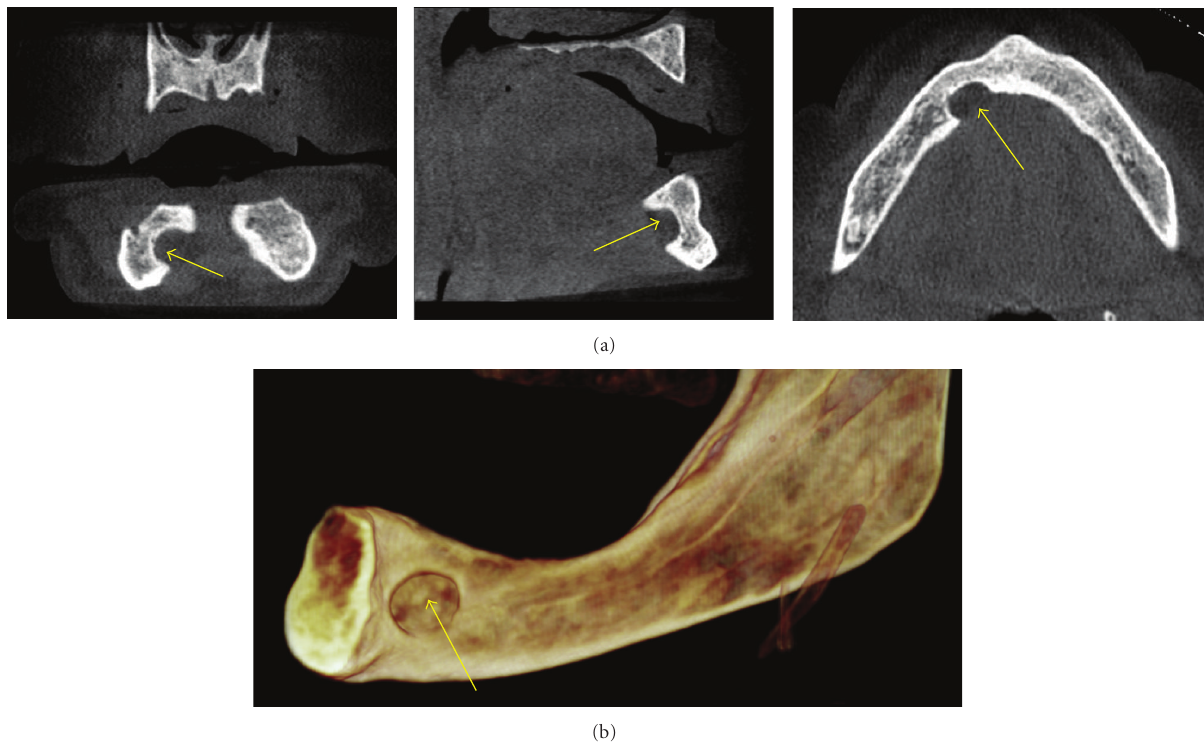
Figure 7: An anterior Stafne defect (ASD) seen as a well-defined area of scooped out bone in the region of the sublingual salivary gland on the right side of the lingual aspect of the mandible on these MPR (arrows) and 3D